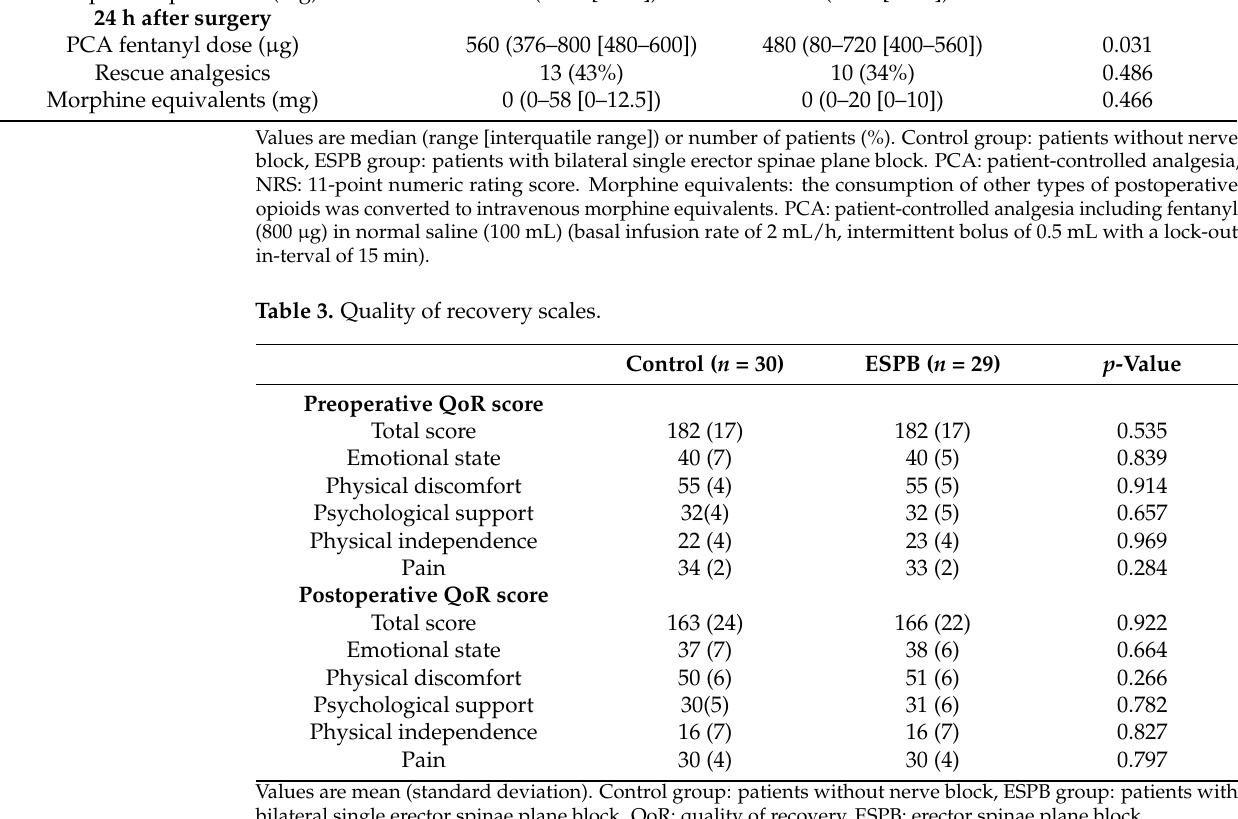
NRS: 11-point numeric rating score. Morphine equivalents: the consumption of other types of postoperative opioids was converted to intravenous morphine equivalents. PCA: patient-controlled analgesia including fentanyl